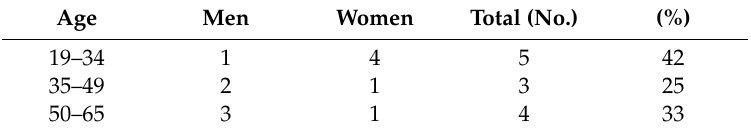
Table 1. Orabi Square interviewee participants characteristics. Source: F.